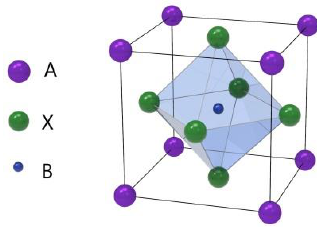
Figure 1. Crystal structure of the perovskite ABX 3 form.